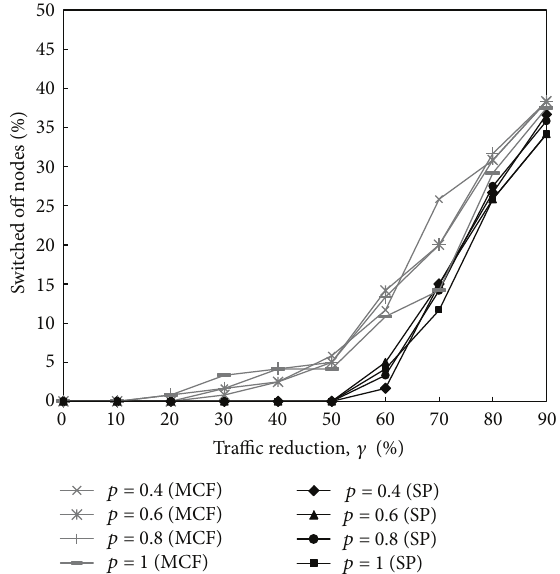
Figure 5: Percentage of switched off nodes obtained using MEE Heuristic with MCF and Dijkstra rerouting approach and in the case of the Network 6-3-4.